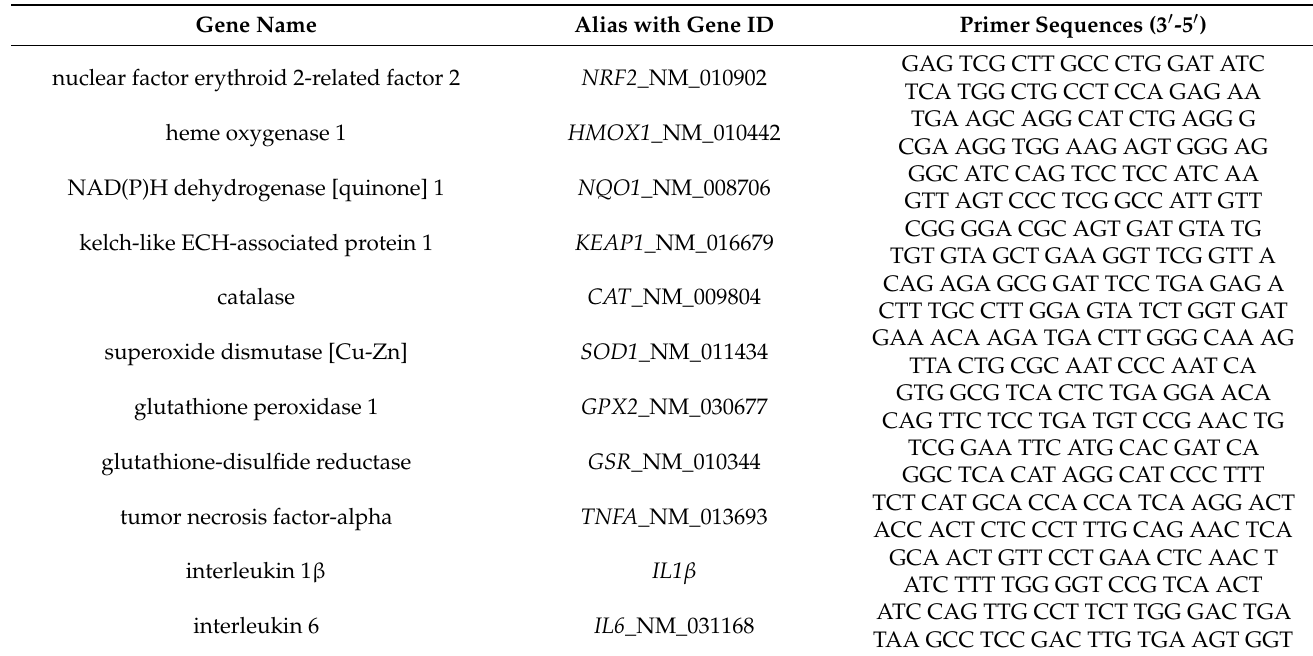
Table A1. Murine gene-specific primers used in quantitative real-time